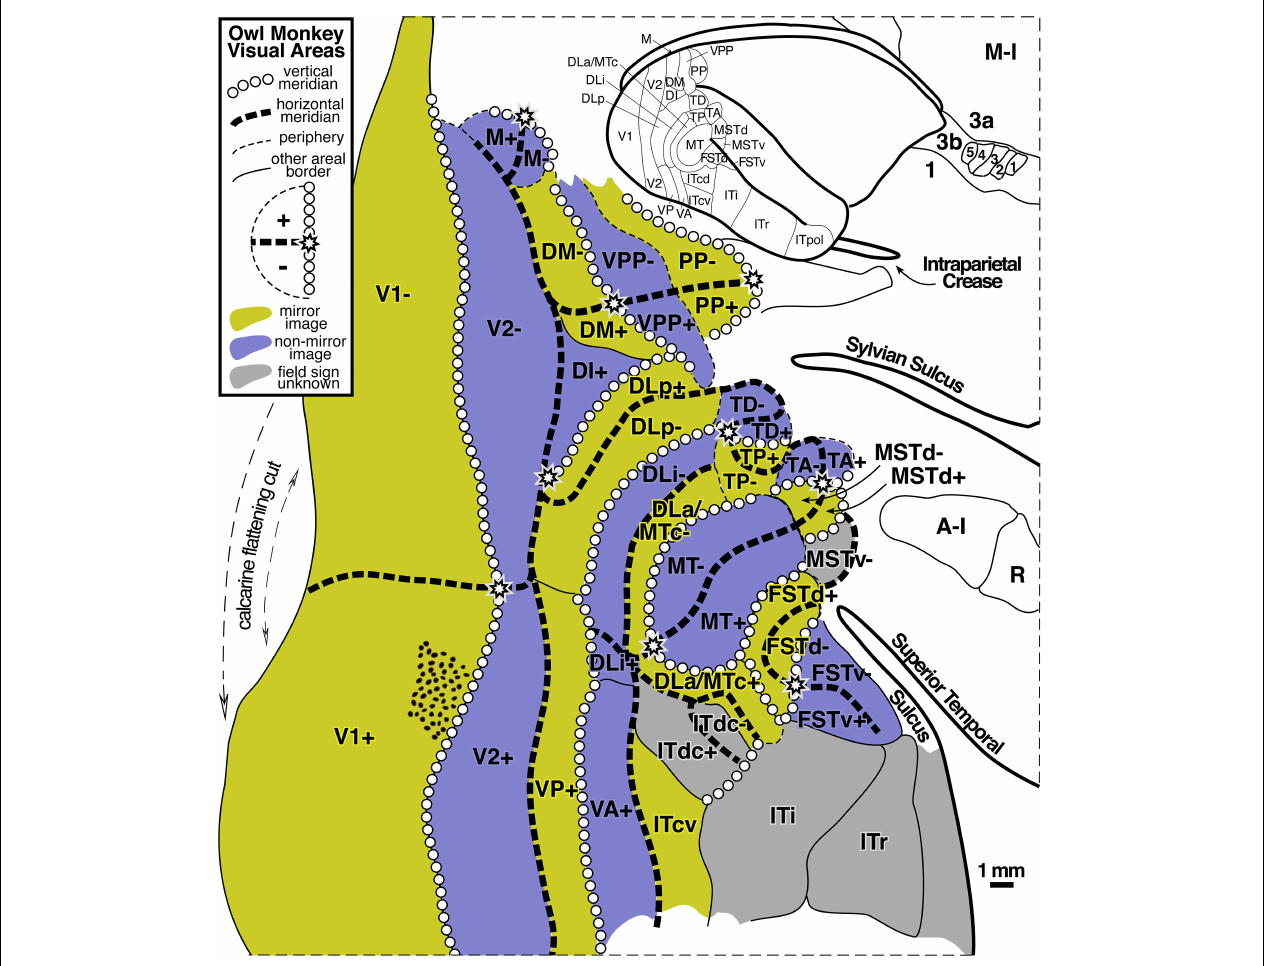
FIGURE 2 | Owl monkey visual areas. Almost all of the 24 areas shown are retinotopic. Many contain partial representations of the visual field. Modified from Sereno et al.